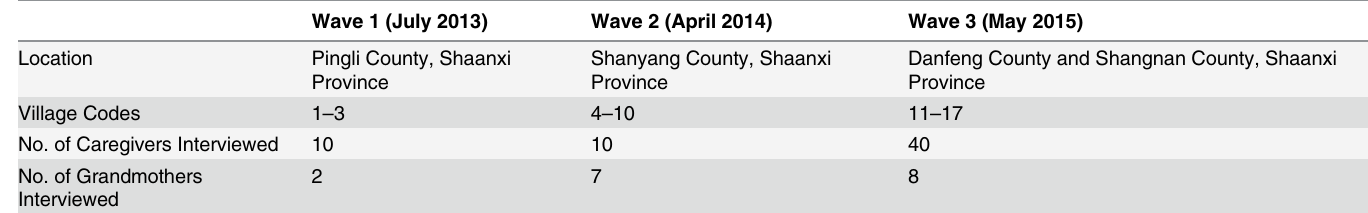
Table 1. Sample Selection and Methodology.